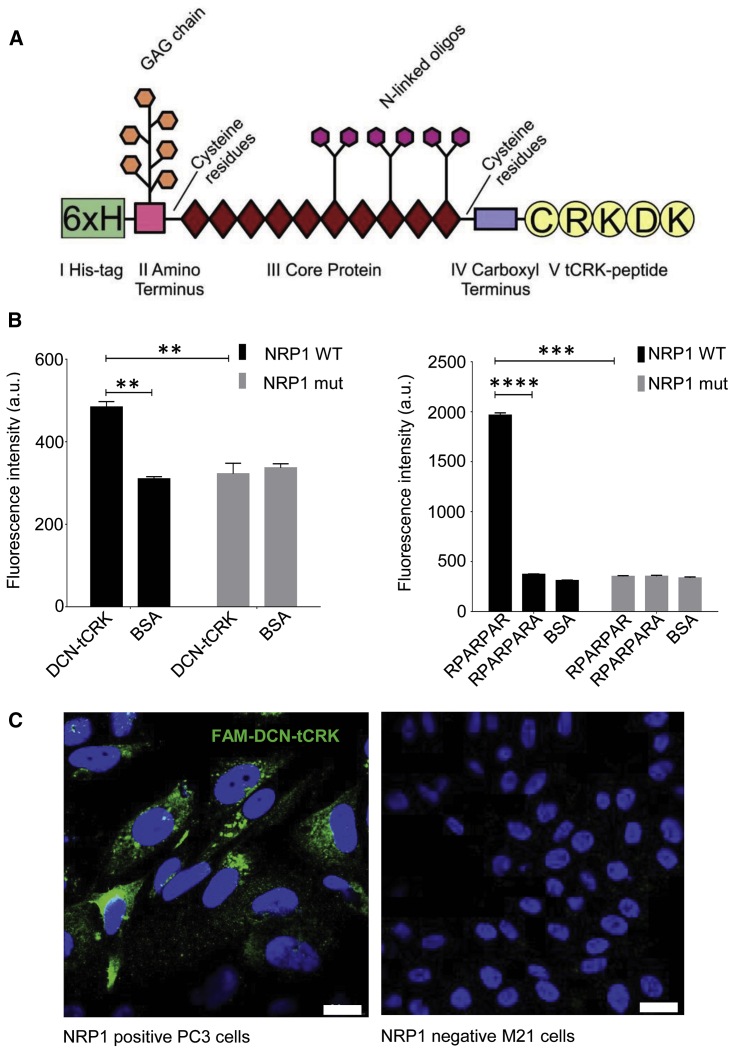
Recombinant DCN-tCRK Protein and Its Binding to Neuropilin-1(A) A schematic representation of the structure of DCN-tCRK. Signal peptide and propeptide of the native DCN were replaced with a 6× His-tag (I) for purification. The His-tag is followed by the amino terminus (II), core protein (III), and carboxyl terminus (IV) of mature DCN proteoglycan. tCRK peptide (V) was cloned on the carboxyl end of the protein. (B) In vitro binding of DCN-tCRK to neuropilin-1 (NRP-1) in vitro. DCN-tCRK (left panel) and peptide controls (right panel, positive peptide [RPARPAR] and negative peptide [RPARPARA]) were immobilized in ELISA plate. Bovine serum albumin (BSA) was included as a non-specific protein control for DCN-tCRK and the peptides. WT and mutant NRP-1 were labeled with FAM and added to the immobilized plate. The binding of the NRP-1 was measured based on fluorescence intensity. Error bars represent SEM. Experiments were repeated with triplicate samples. ∗∗p < 0.01, ∗∗∗p < 0.001, ∗∗∗∗p < 0.0001, Student’s unpaired t test. (C) Internalization of DCN-tCRK in the NRP-1-positive cells. FAM-labeled DCN-tCRK was incubated with PC3 and M21 cells positive and negative for NRP-1 expression, respectively. DCN-tCRK was detected by anti-FAM immunostaining (green). Nuclei were counterstained with DAPI (blue). Representative images from three independently studied experiments are shown. Scale bars, 20 μm.